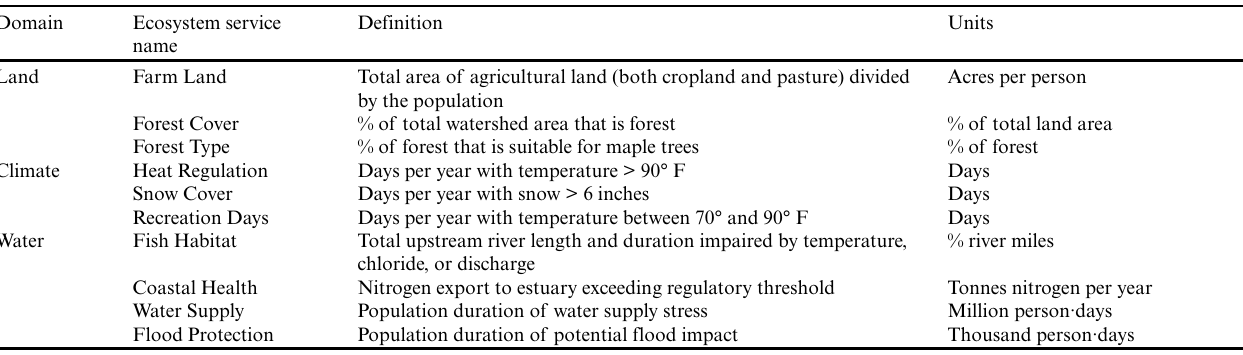
Table 1 . Ecosystem services evaluated by